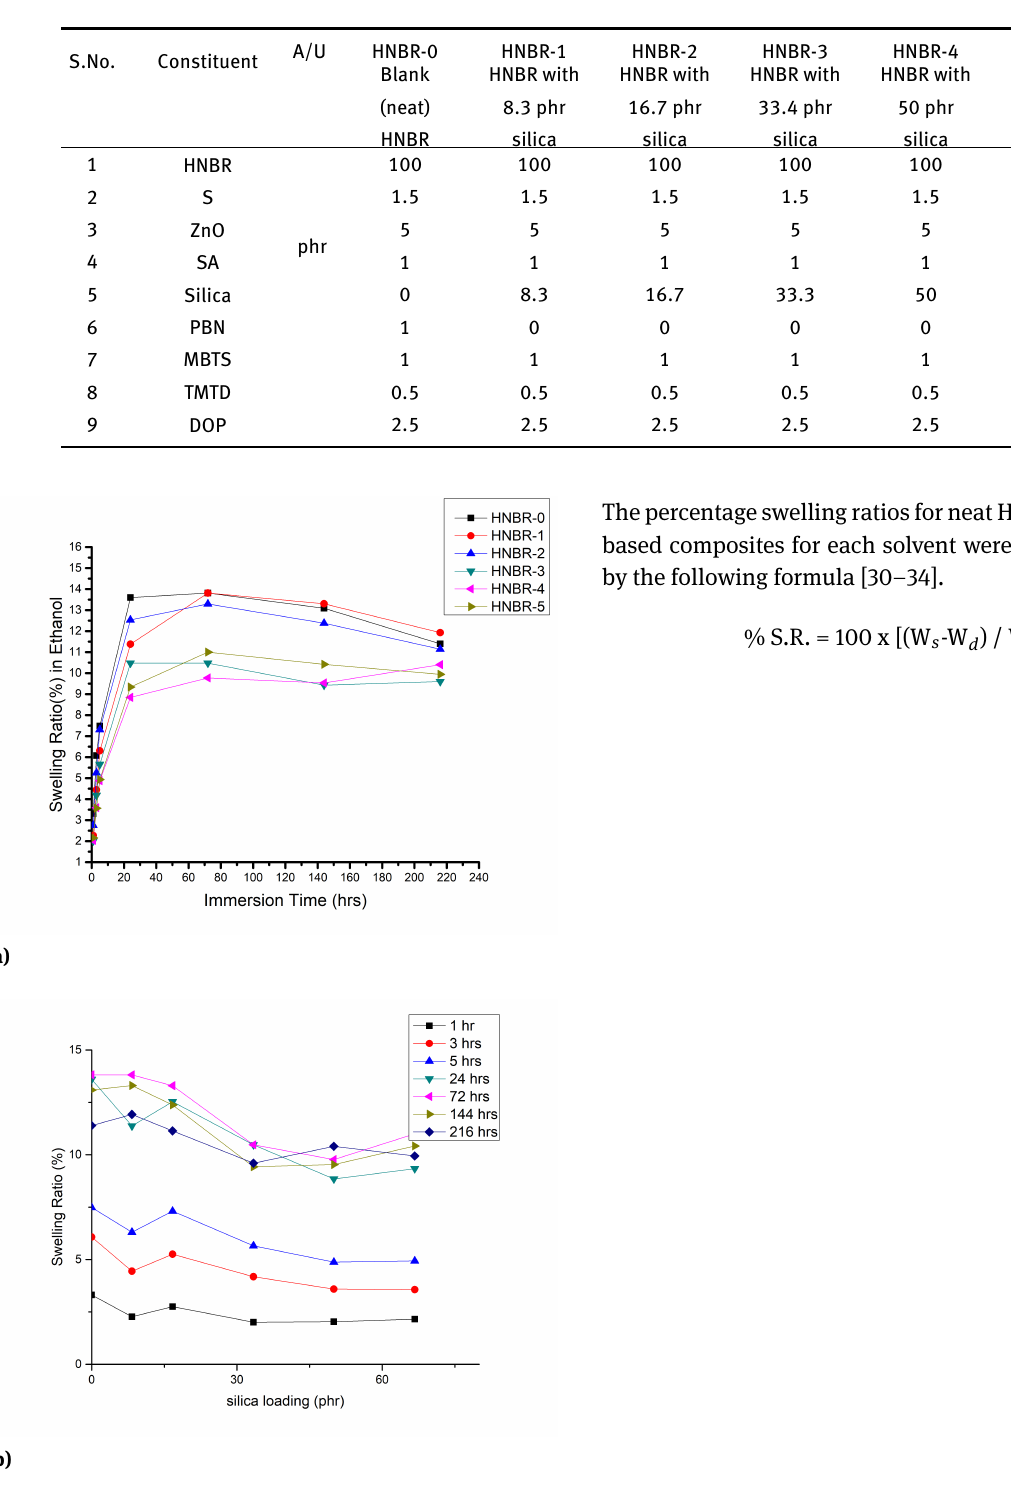
Figure 2: Swelling behavior of HNBR in ethanol (a) swelling ratio vs. swelling time (b) swelling ratio vs. silica